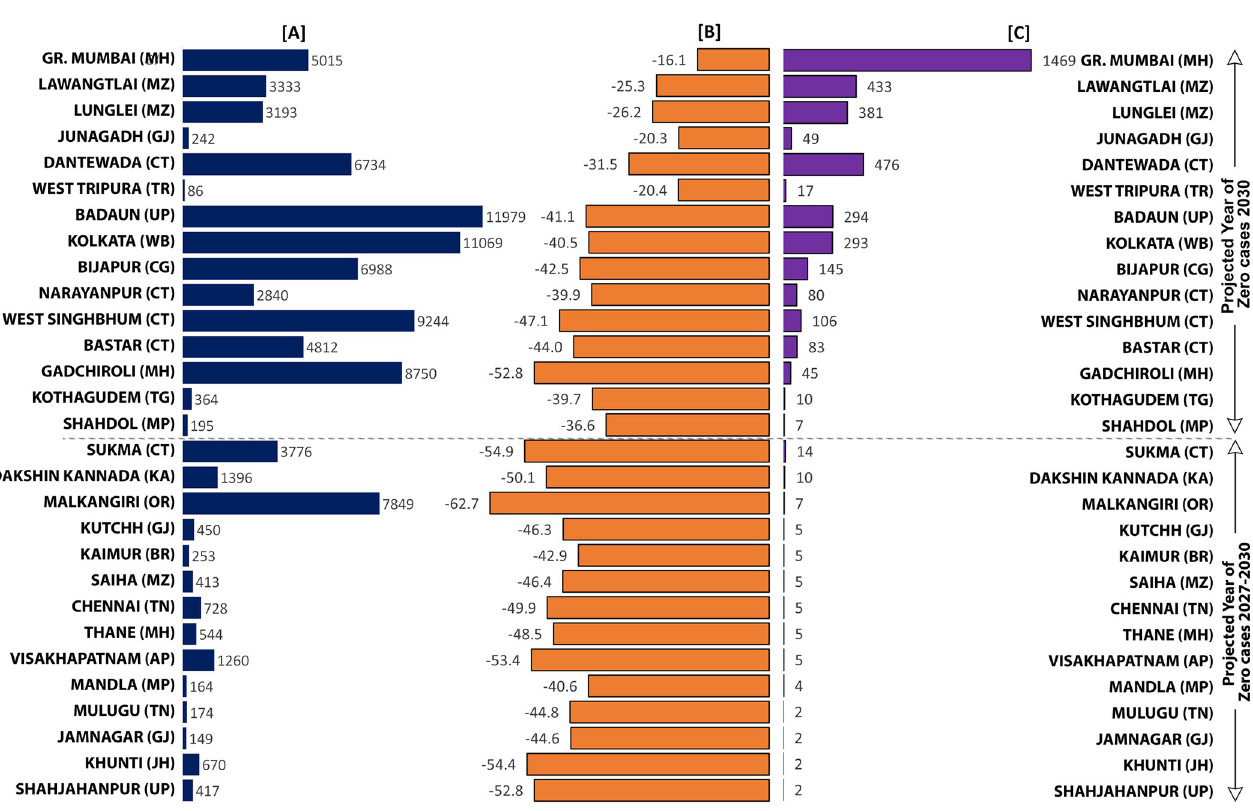
Fig 3. Distribution of malaria indicators ((A) Total malaria cases in 2020, (B) Maximum AROC in the last three years (2018–20) (C) projected case of malaria for 2027 using the maximum rate of reduction in the last three years (2018–20)) in the cohort of 15 districts of India that are likely to achieve zero malaria cases status post-2030 if they progress as per their current rate of reduction in malaria cases. State Abbreviations: AP-Andhra Pradesh, BR-Bihar, CT-Chhattisgarh, GJ-Gujarat, JH-Jharkhand, KA-Karnataka, MP-Madhya Pradesh, MH-Maharashtra, MZ-Mizoram, OR-Odisha, TN-Tamil Nadu, TG-Telangana, TR-Tripura, UP-Uttar Pradesh, WB-West